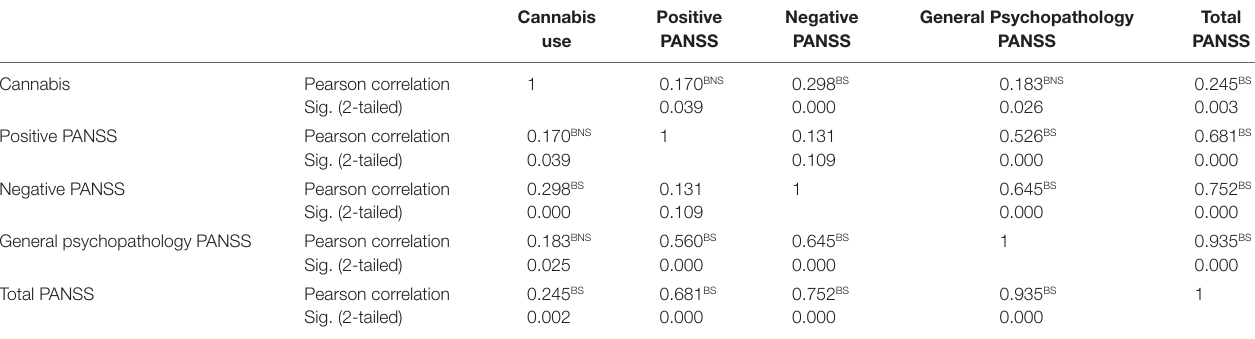
TaBle 3 | correlation between cannabis use and positive and negative symptoms scales in schizophrenia ( N = 150).